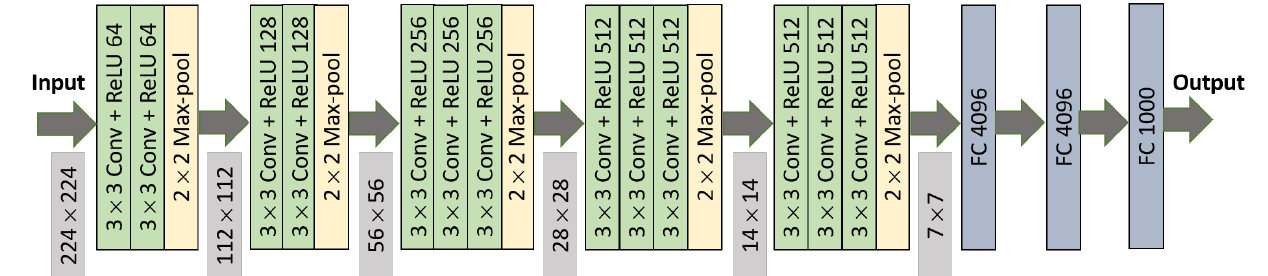
Figure 6. VGG16 architecture for 224 × 224 input image dimension.